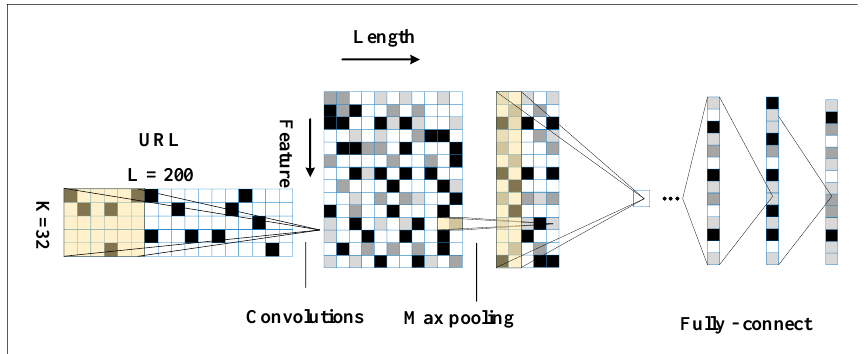
Figure 4. Improved